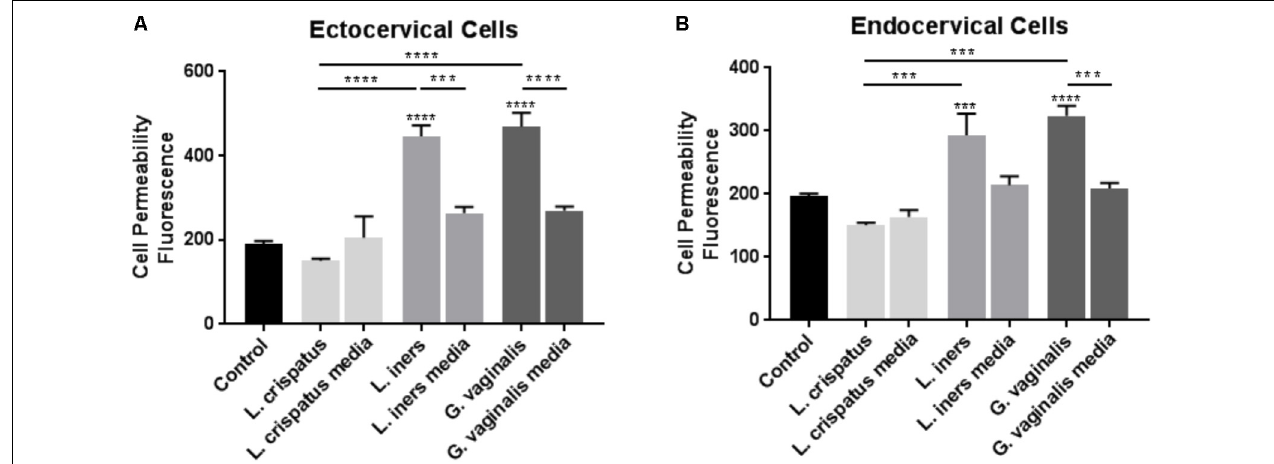
FIGURE 1 | Cell permeability is increased in ectocervical and endocervical cells after exposure to L. iners and G. vaginalis but not L. crispatus bacteria-free supernatants. Cell permeability was measured in ectocervical cells (A) and endocervical cells (B) after a 48 h exposure to bacteria-free supernatants (10% v/v) from L. crispatus , L. iners , and G. vaginalis compared to non-treated control cells. Bacterial growth media alone acted as a negative control for the three bacteria-free supernatants tested. Cell permeability is expressed as fluorescence OD measurements from a fluorescent plate reader and is indicative of the movement of FITC-dextran from the top to the bottom insert of a transwell chamber system. Values are mean ± SEM. Asterisks over the individual bars represent comparisons to control; asterisks over solid lines represent comparisons between treatment groups. ∗ p < 0.05, ∗∗ p < 0.01, ∗∗∗ p < 0.001, ∗∗∗∗ p < 0.0001.